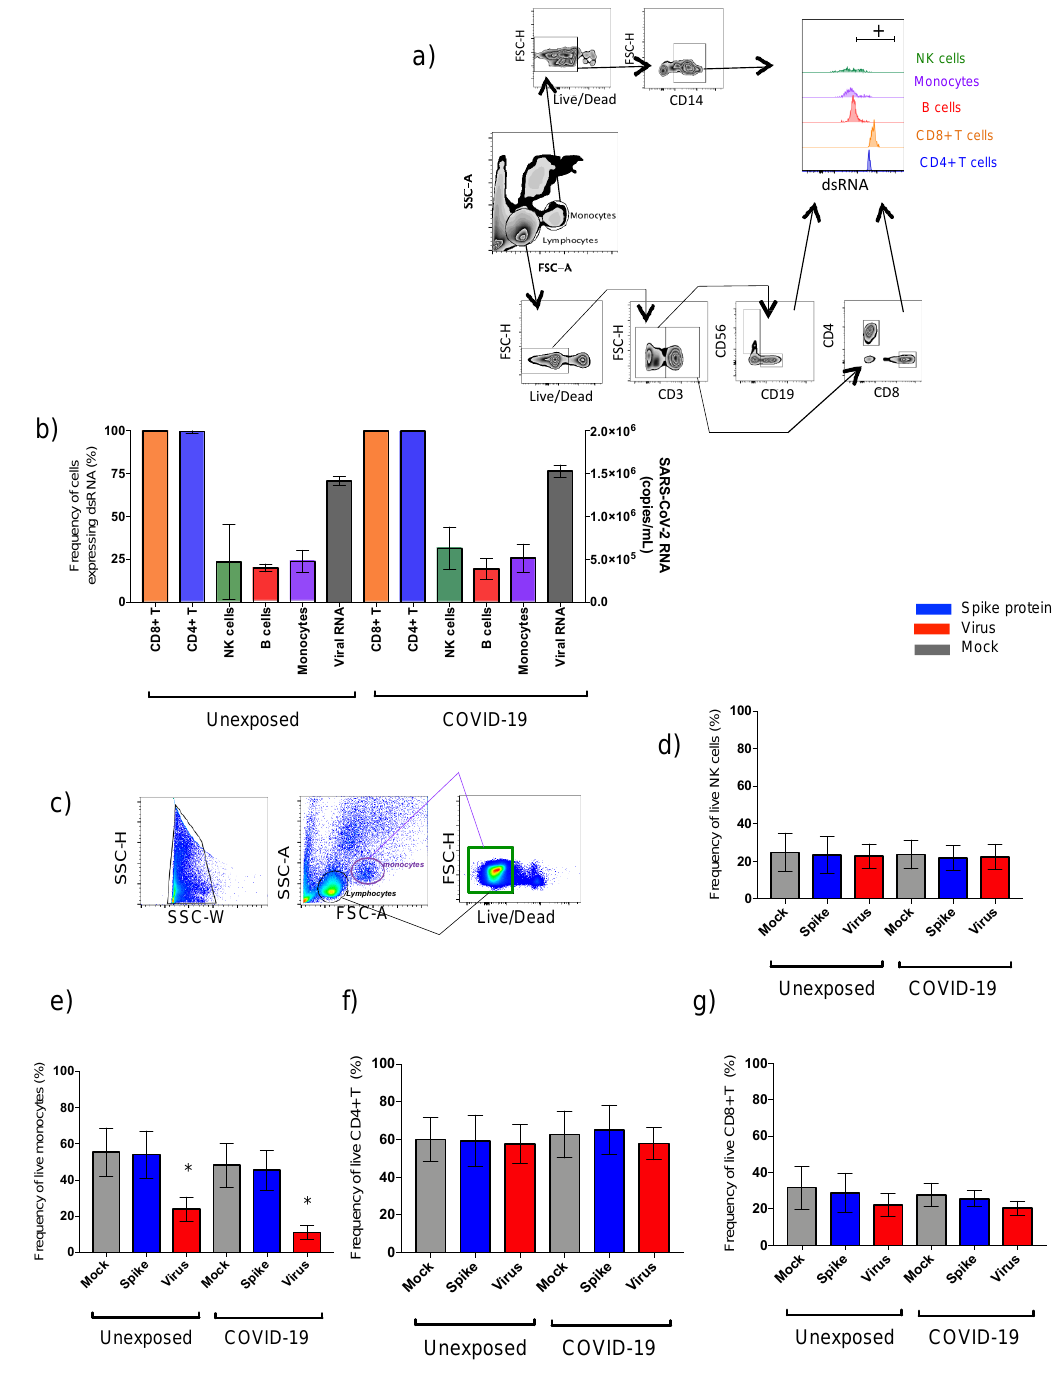
Figure 1. Presence of SARS-CoV-2 in PBMC and the percentage of live phenotypes exposed to spike protein and to live SARS-CoV-2. Gate strategy to get the subpopulations evaluated. ( a ). Viral load of RNA detected on supernatant from unexposed and COVID-19 PBMC cultured with live virus and frequency of double-strand (ds) RNA detection in different phenotypes, as CD8 + T, CD4 + T, natural killer (NK), B lymphocytes, and monocytes after in vitro cultivation ( b ). Gate to define total live PBMCs are represented with green lines (FSC-H vs. Live/Dead) with lymphocytes in black and monocytes in purple on the backgating ( c ). Subsequently, to separate natural killer from CD4 + and CD8 + T cells, we used CD56 marker to natural killer, and CD3 marker to define the T-cells subpopulation. Data from PBMC cultured with spike protein (blue) and SARS-CoV-2 (red) on total live natural killer (NK: CD56 + CD3 − ) ( d ), total live monocytes ( e ), and total live T lymphocytes (CD3 + CD4 + ) ( f ) and (CD3 + CD8 + ) ( g ). The data are representative of 2–5 different experiments. * p < 0.05, ** p < 0.01, and *** p <